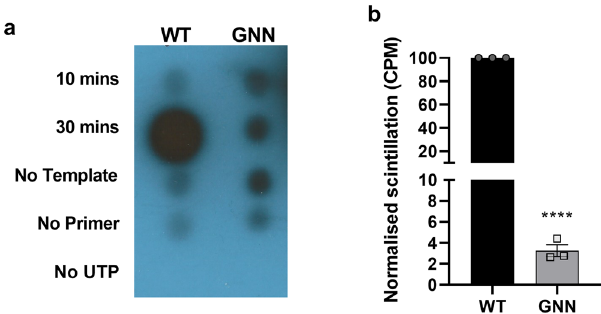
Fig. 2 Polymerase activity assay. Polymerase activity assays were used to determine activity of recombinant 3D pol . a Dot-blot showing that incorporation of [ α - 32 P] UTP is only possible when all assay components are included. b Quanti fi cation of levels of incorporated radiolabelled nucleotides after 30 min incubation by scintillation counts per minute normalised to WT ( n = 3 ± SEM, analysed by two-tailed unpaired t test, **** p < 0.0001). The GNN mutant indicates background